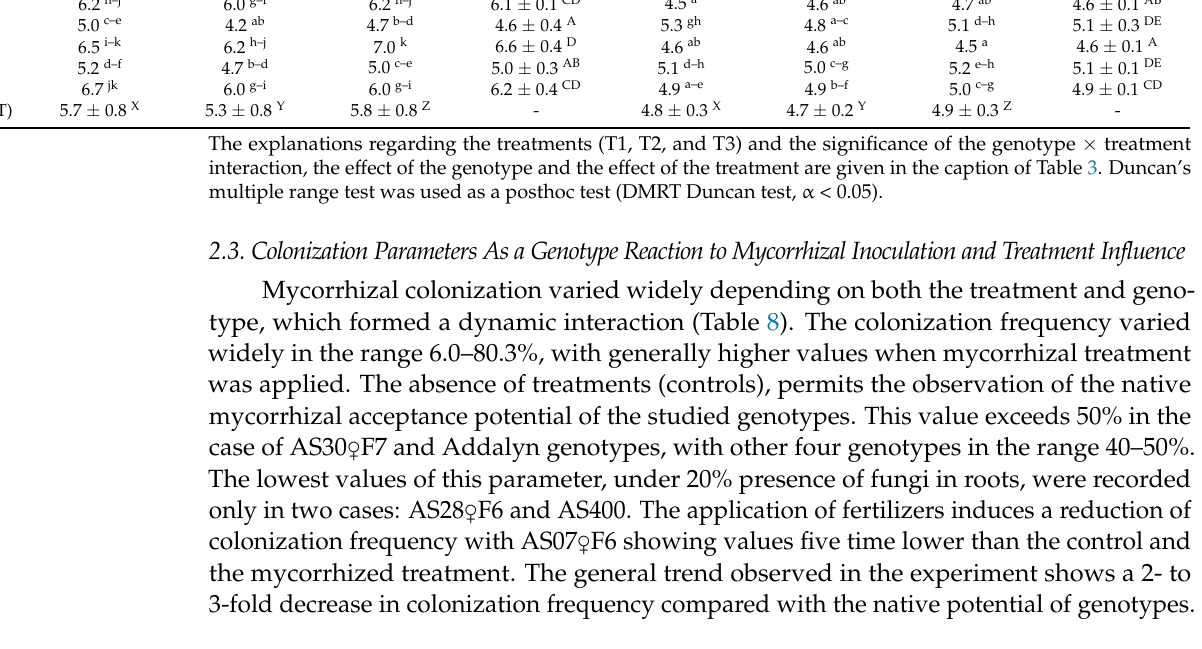
Table 8. The combined influence of genotype and treatment on mycorrhizal